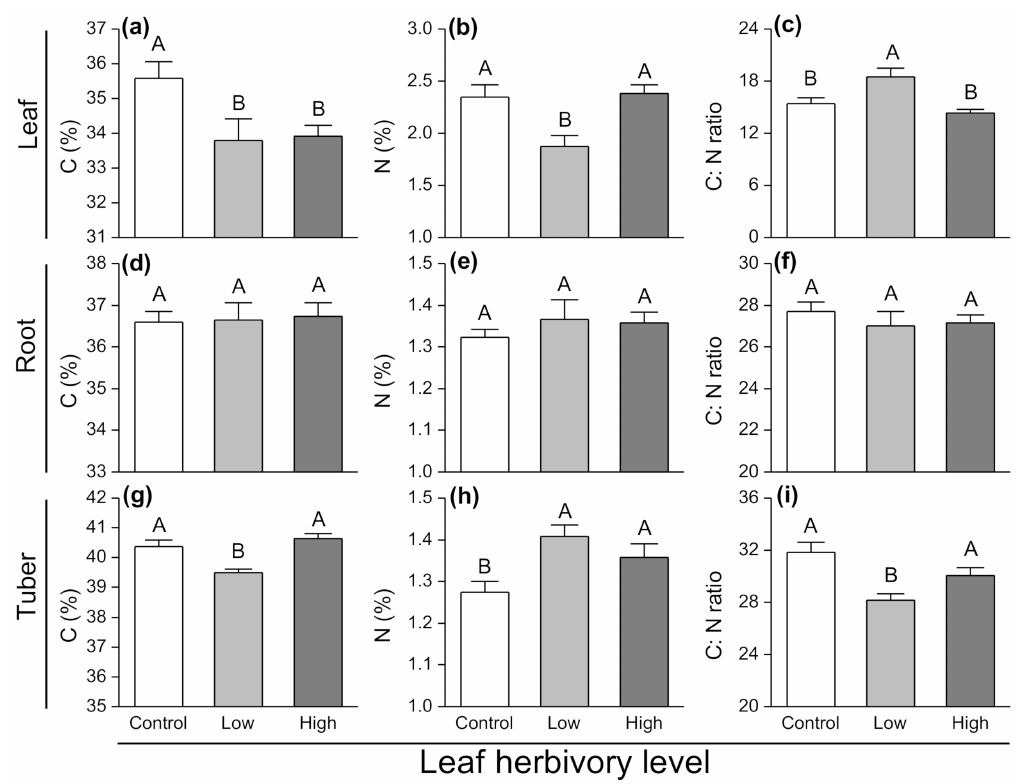
Figure 4. Changes in ( a – c ) C content ( d – f ), N content and ( g – i ) C:N ratio in di ff erent plant components (leaf, root and tuber) of potato plants exposed to di ff erent herbivory levels of Phthorimaea operculella . Data are means ± SE. Di ff erent letters indicate significant di ff erences among treatments ( p < 0.05) based on post hoc Tukey’s HSD